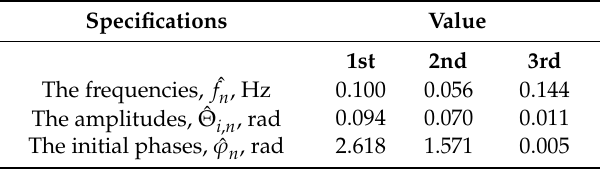
Figure 9. The signal after the compensation of each sinusoidal function: ( a ) 1st sinusoidal function; ( b ) 2nd sinusoidal function; ( c ) 3rd sinusoidal function. Table 3. The parameters of the matched values of sinusoidal functions.